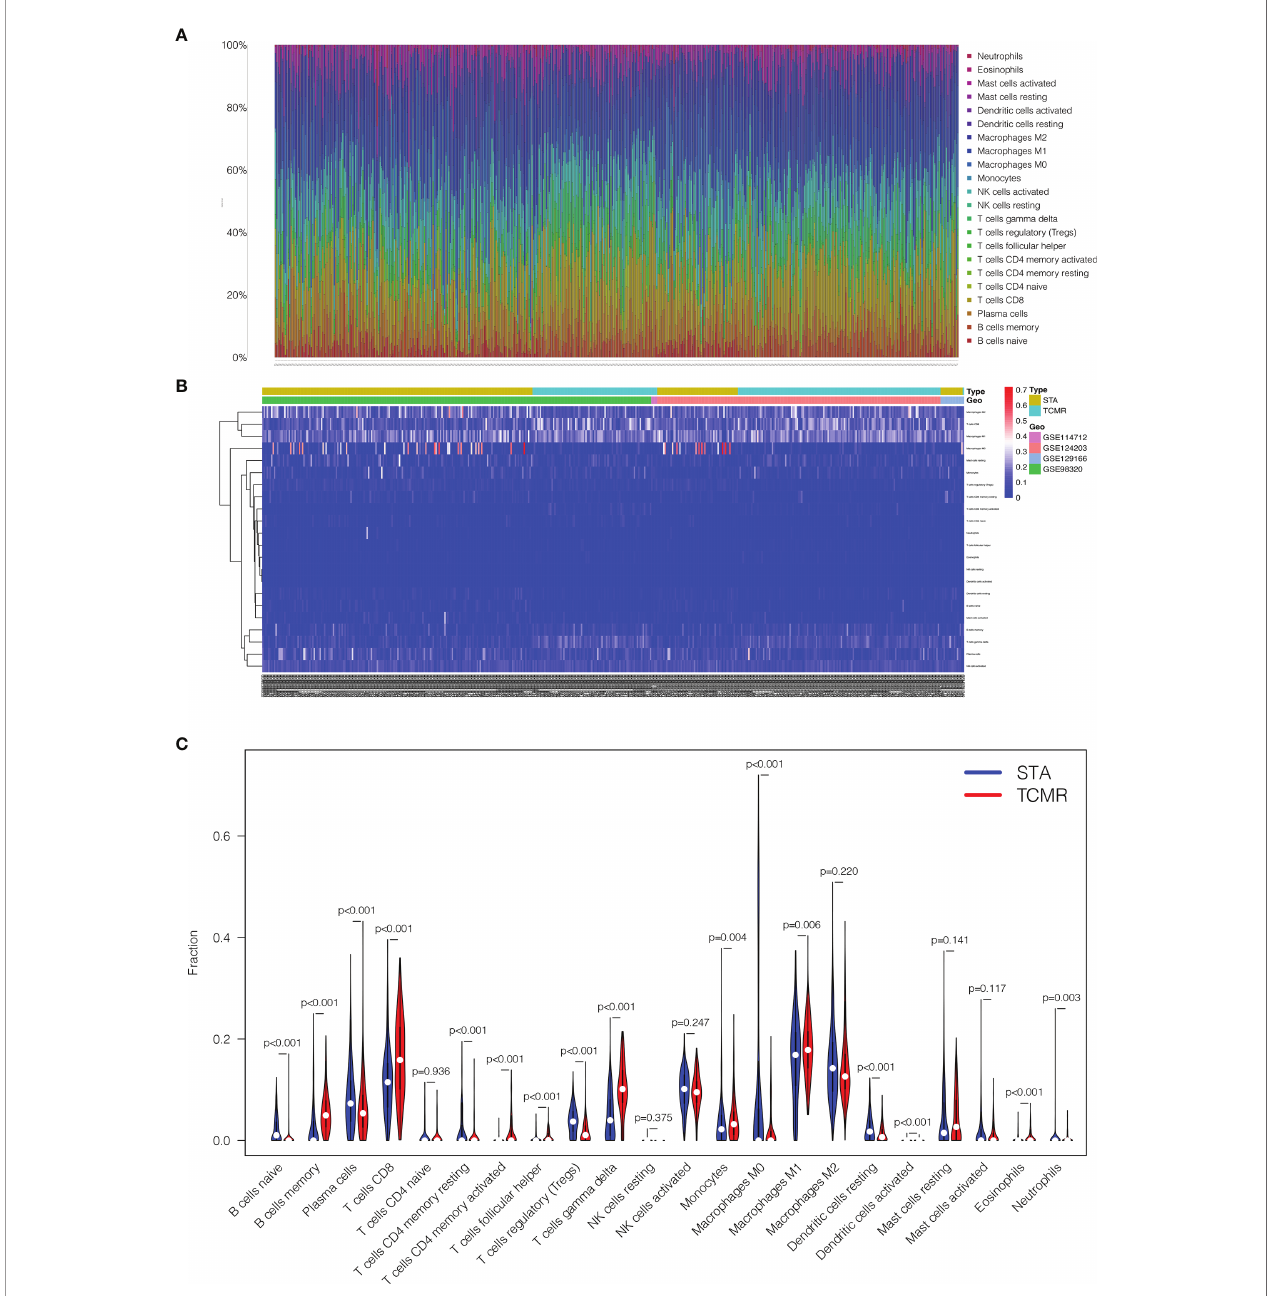
FIGURE 5 | Comparisons of 22 important immune fractions between TCMR and STA groups. (A) The Speci fi c 22 immune fractions represented by various colors in each sample were shown in the barplot. (B) Distributions of immune cells in TCMR and STA samples in the heatmap. (C) Comparison of 22 immune cell subtypes between TCMR and STA